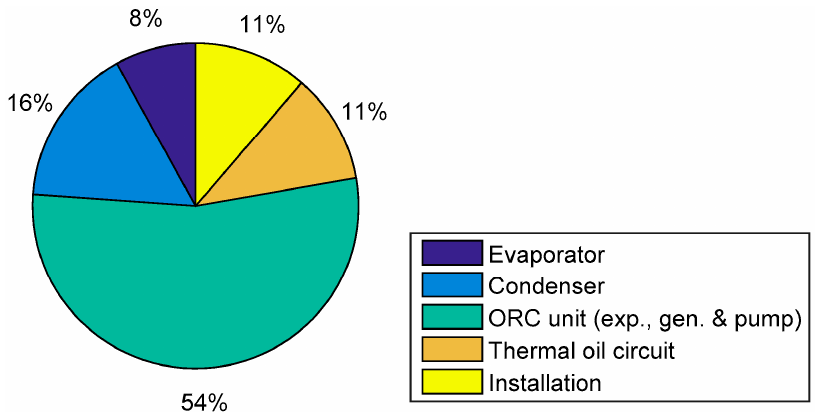
Figure 2. Diagram of the investment costs of the ORC case